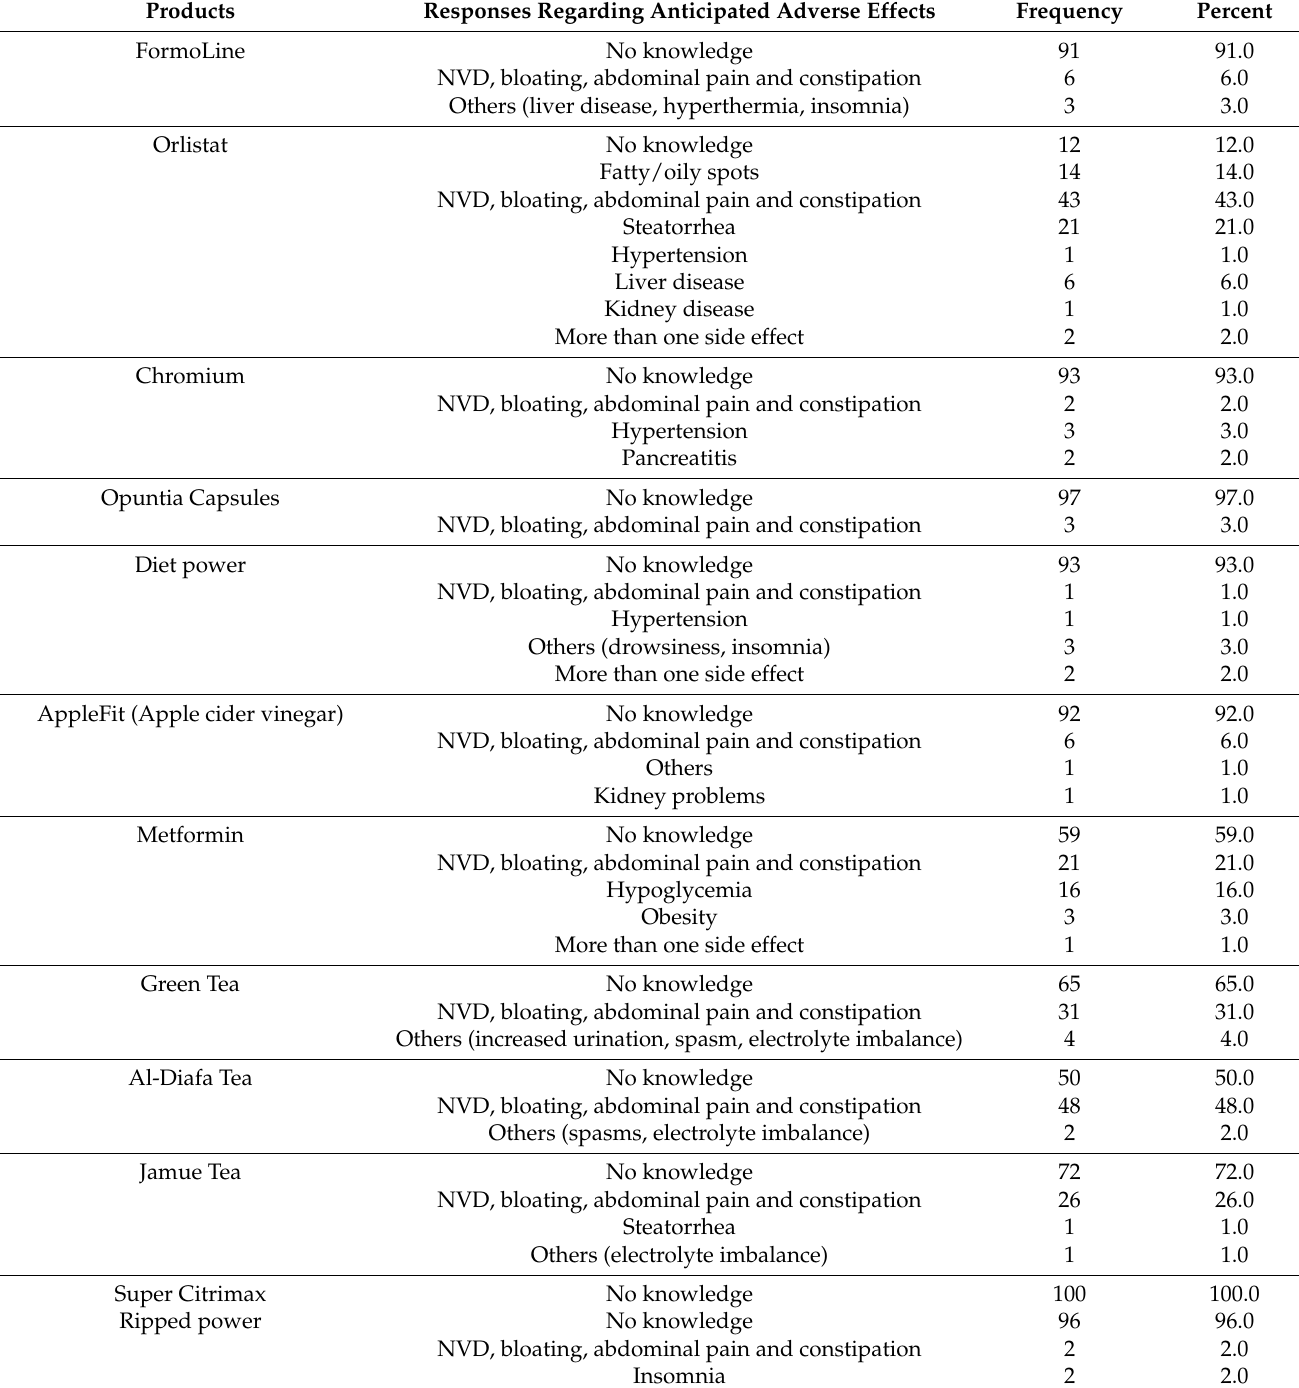
Table 4. Responses of pharmacists regarding adverse effects of weight loss